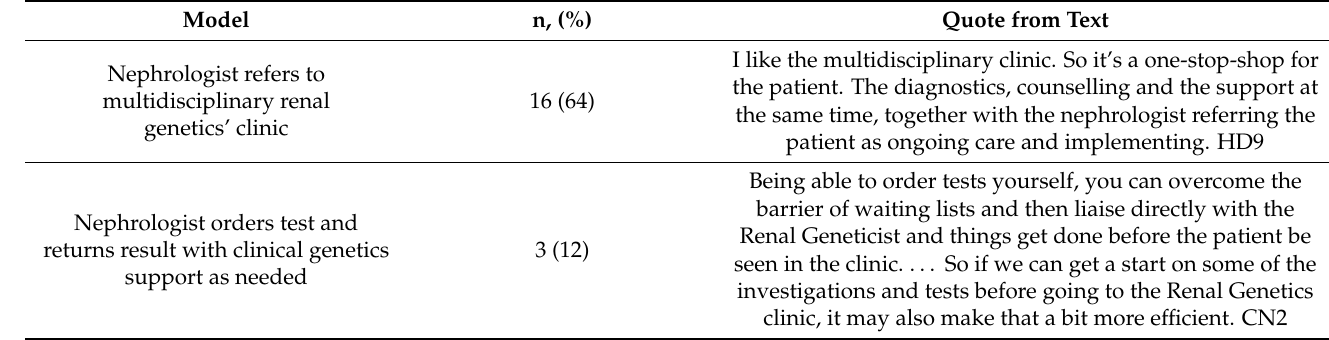
Table 3. Model of service